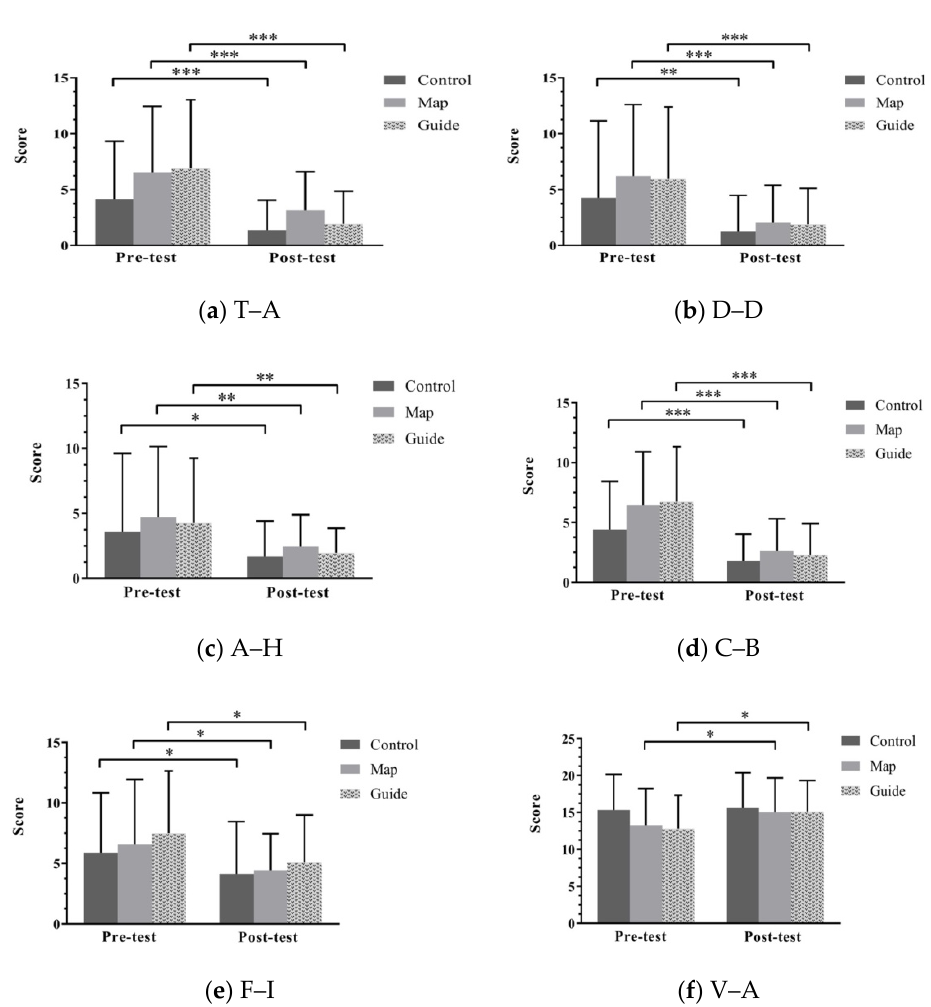
Figure 4. Pretest–posttest comparisons of psychological measures across the three groups. Abbreviations: ( a ) T–A, tension–anxiety; ( b ) D–D, depression–dejection; ( c ) A–H, anger–hostility; ( d ) C–B, confusion–bewilderment; ( e ) F–I, fatigue–inertia; ( f ) V–A, vigor–activity. Note: * p < 0.05, ** p < 0.01, *** p < 0.001